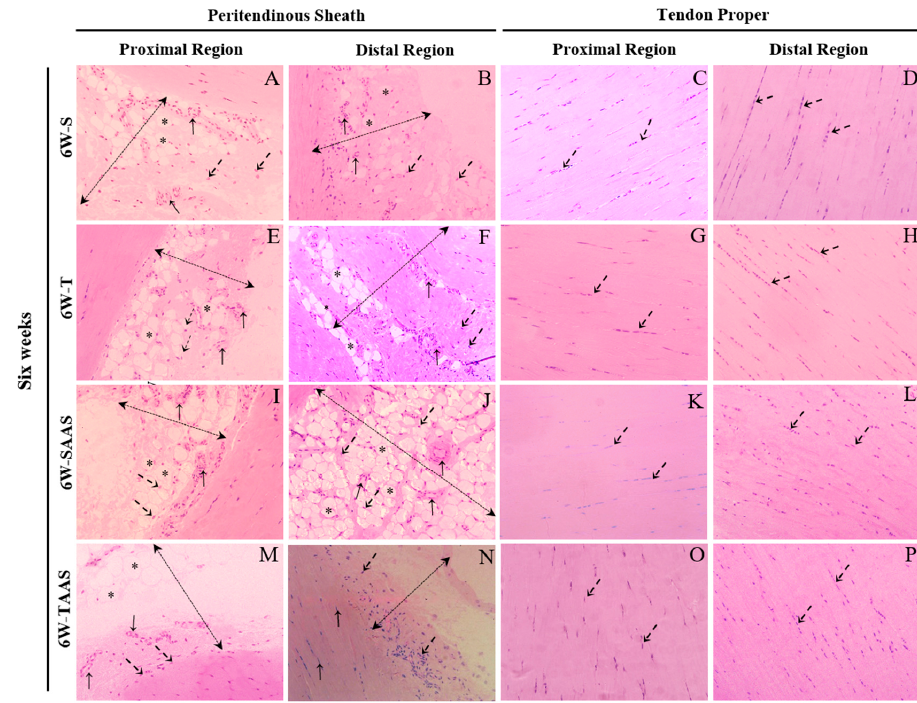
Figure 5. Longitudinal sections of the proximal and distal regions of the CT in the 6W group stained with hematoxylin-eosin. 6W-S: In the peritendinous sheath (dashed double-head arrow), the proximal ( A ) and distal ( B ) regions show blood vessels (arrows), cells (dashed arrows), and adipose cells (asterisks. In the tendon proper, the proximal ( C ) and distal ( D ) regions show cells (dashed arrows). 6W-T: In the peritendinous sheath (dashed double-head arrow), the proximal ( E ) and distal ( F ) regions show blood vessels (arrows), cells (dashed arrows), and adipose cells (asterisks). In the tendon proper, the proximal ( G ) and distal ( H ) regions show cells (dashed arrows). 6W-SAAS: In the peritendinous sheath (dashed double-head arrow), the proximal ( I ) and distal ( J ) regions show blood vessels (arrows), cells (dashed arrows), and adipose cells (asterisks). In the tendon proper, the proximal ( K ) and distal ( L ) regions show cells (dashed arrows). 6W-TAAS: In the peritendinous sheath (dashed double-head arrow), the proximal ( M ) and distal ( N ) regions show blood vessels (arrows), cells (dashed arrows), and adipose cells (asterisks). In the tendon proper, the proximal ( O ) and distal ( P ) regions show cells (dashed arrows). Original magnification, 400×. Scale bars 20 µm.